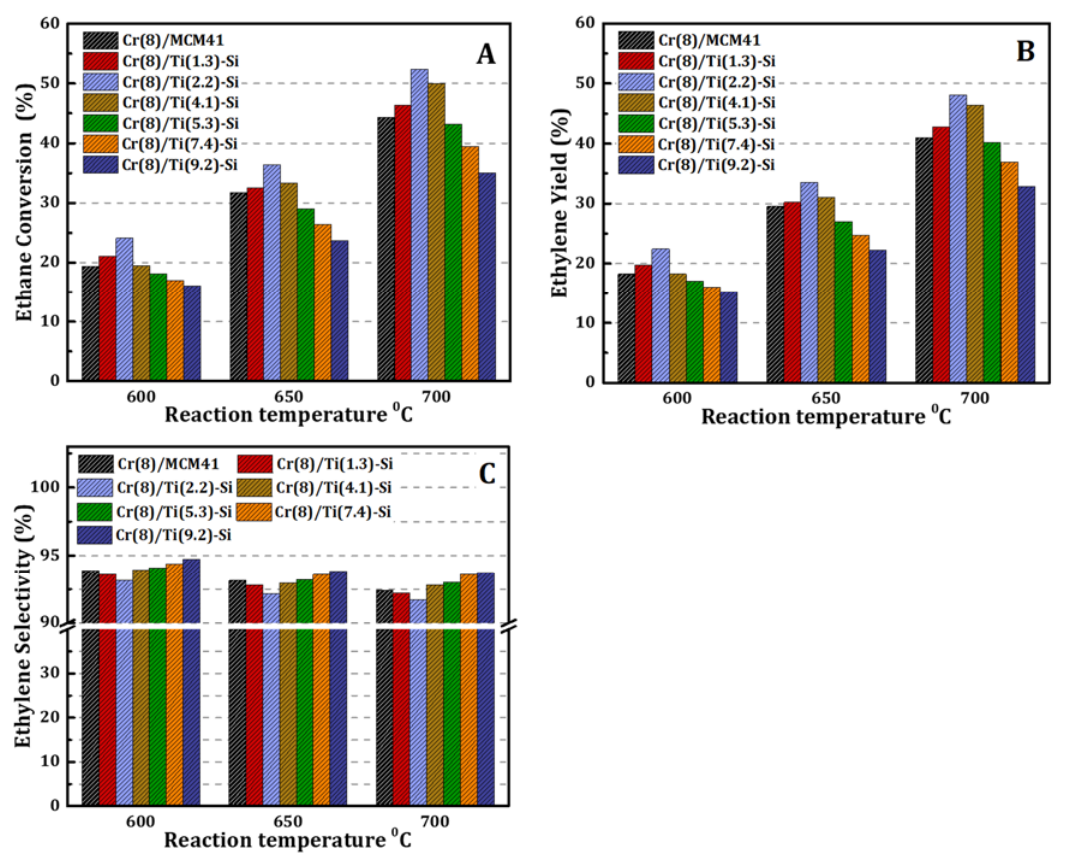
Figure 7. Effect of Ti loading on ( A ) ethane conversions and ( B ) ethylene selectivity and ( C ) ethylene